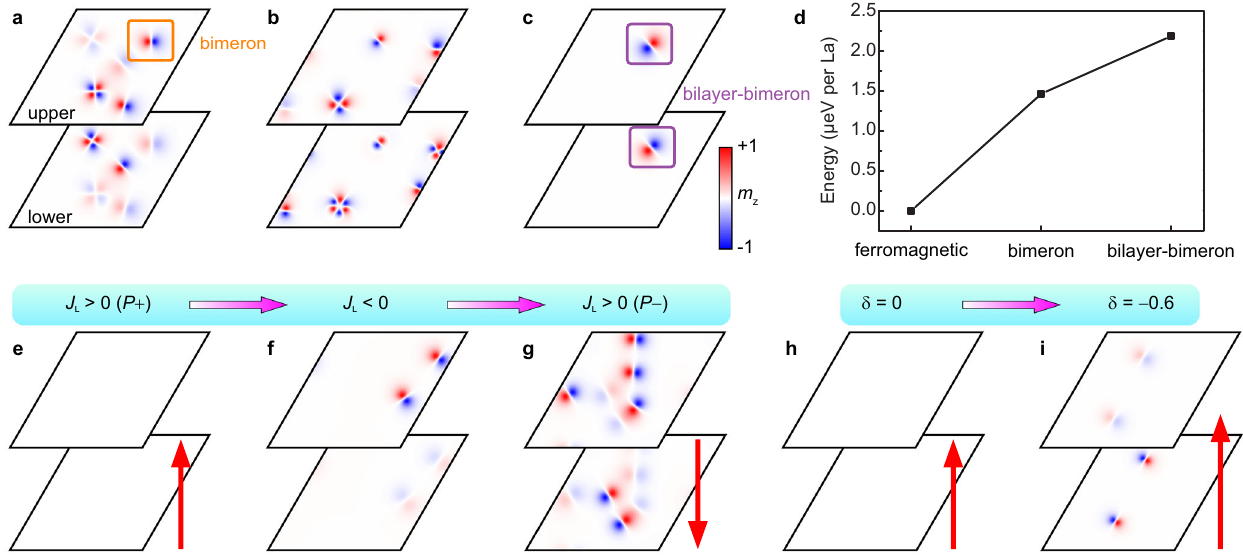
Fig. 4 Frustrated bimeron texture in 3 R LaBr 2 bilayer. a – c represent the spin texture of δ = − 0.4~0, δ = − 0.6, and δ = − 0.8 Å in LaBr 2 with polarization along positive z direction, respectively. d is the relative energy of FM, bimeron, and bilayer-bimeron states. e – g and h – i are spin texture evolution from FM initial state caused by polarization inversion and enhancement,